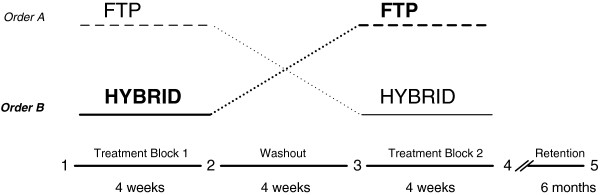
Cross-over research design. All participants received both FTP (control) and HYBRID (experimental) treatments, randomized to order. Order A received FTP first, followed by a washout period, and then participated in the HYBRID treatment. Order B (highlighted in bold) received the HYBRID first followed by the washout and then FTP. Treatment blocks were each 4 weeks separated by a 4-week washout period. Evaluations were conducted at baseline (1), following the first treatment block (2), following the washout period (3), following the second treatment block (4) and following a 6-month no treatment retention period (5).